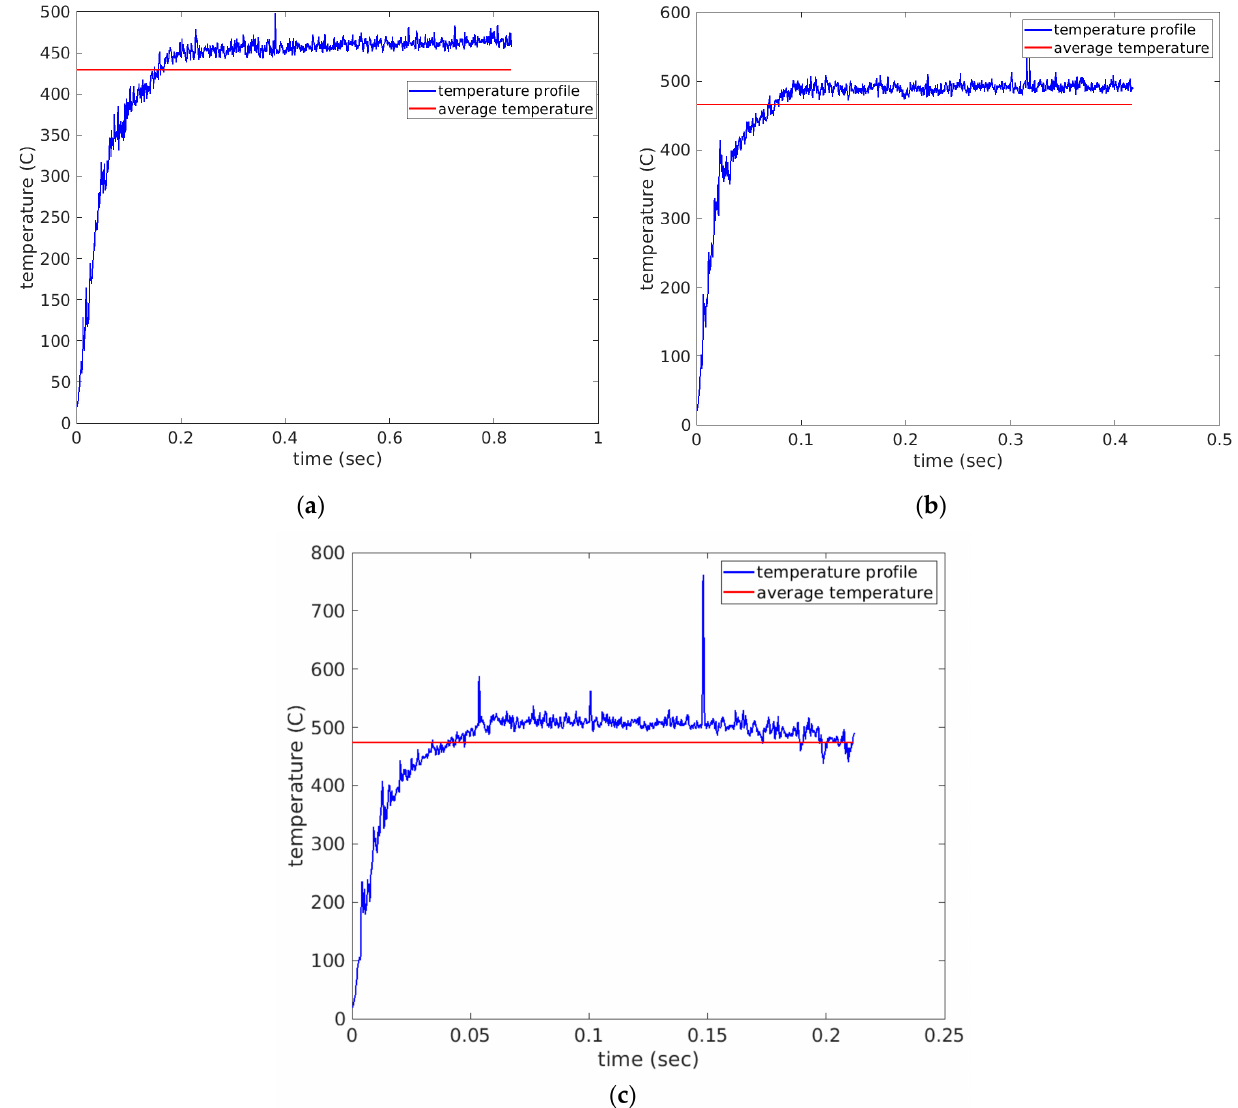
Figure 9. Cutting temperature profiles observed under simulations ( a ) scenario 4 of feed rate 0.375 mm/rev and 1000 spindle rpm ( b ) scenario5 of feed rate 0.375 mm/rev and 2000 spindle rpm and ( c ) scenario 6 of feed rate 0.375 mm/rev and 3000 spindle